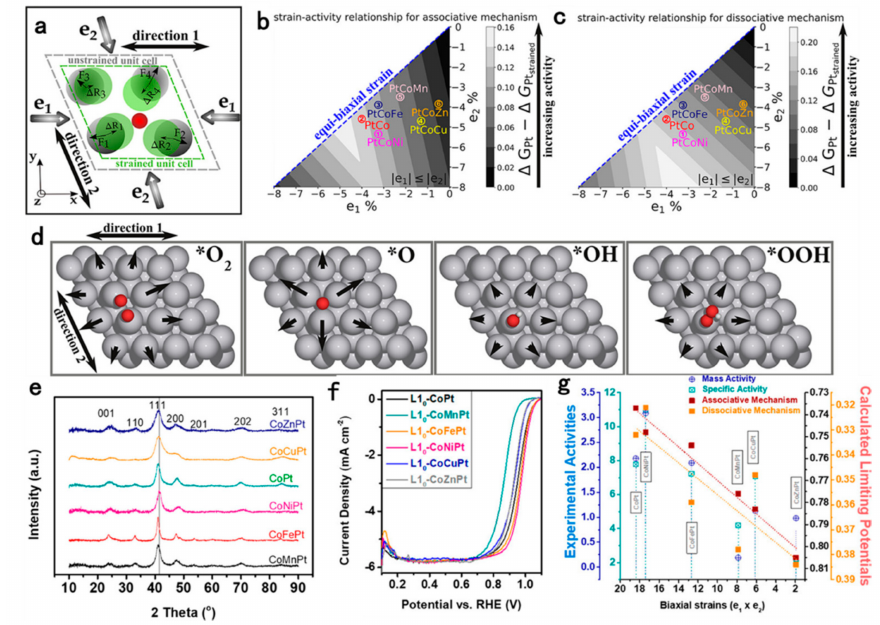
Figure 9. ( a ) Illustration of the in-plane components of the adsorbate-induced eigenforces and the displacement caused by an applied strain. Calculated 2D volcano plots of strained Pt (111) surfaces using the eigenforce model for ( b ) the dissociative mechanism and ( c ) the associative mechanism. The CoMPt (circles) represents L1 0 -alloyed Pt (111) surfaces in the DFT-optimized lattice constants of their respective ternary L1 0 -CoMPt alloy. e 1 and e 2 represent the percent strains experienced by the Pt (111) surface in directions 1 and 2, respectively. The numbers on the volcano rank the L1 0 strained surfaces in terms of experimentally observed specific activity (SA). ( d ) In-plane components of eigenforces induced by the geometrically optimized adsorbates on the unstrained Pt (111) surface. ( e ) XRD patterns of as-synthesized L1 0 -CoMPt alloy. ( f ) LSV curves of C-L1 0 -CoPt and L1 0 -CoMPt NPs (M = Mn, Fe, Co, Ni, Cu, Zn) collected in O 2 -saturated 0.1 M HClO 4 at room temperature. ( g ) Plot of experimental activities (MA and SA) and calculated limiting potential of C-L1 0 -CoPt